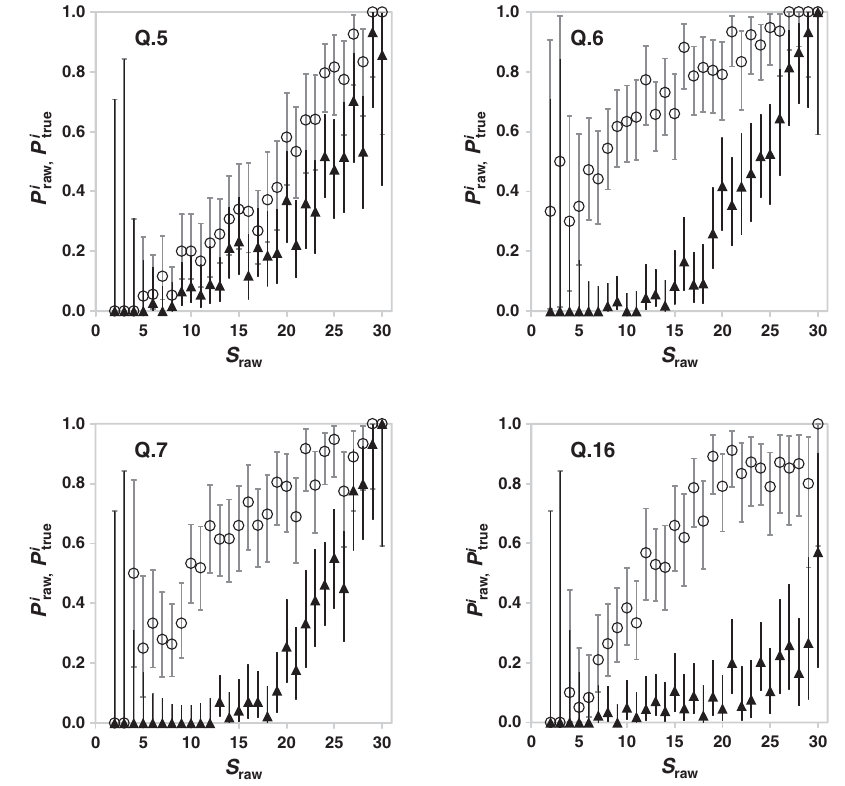
(vertical axis, black triangle) of Q.5, 6, 7, and 16 for each group of students with a true , gray with caps; P i , black without caps) indicate the Clopper-Pearson 95% confidence raw true